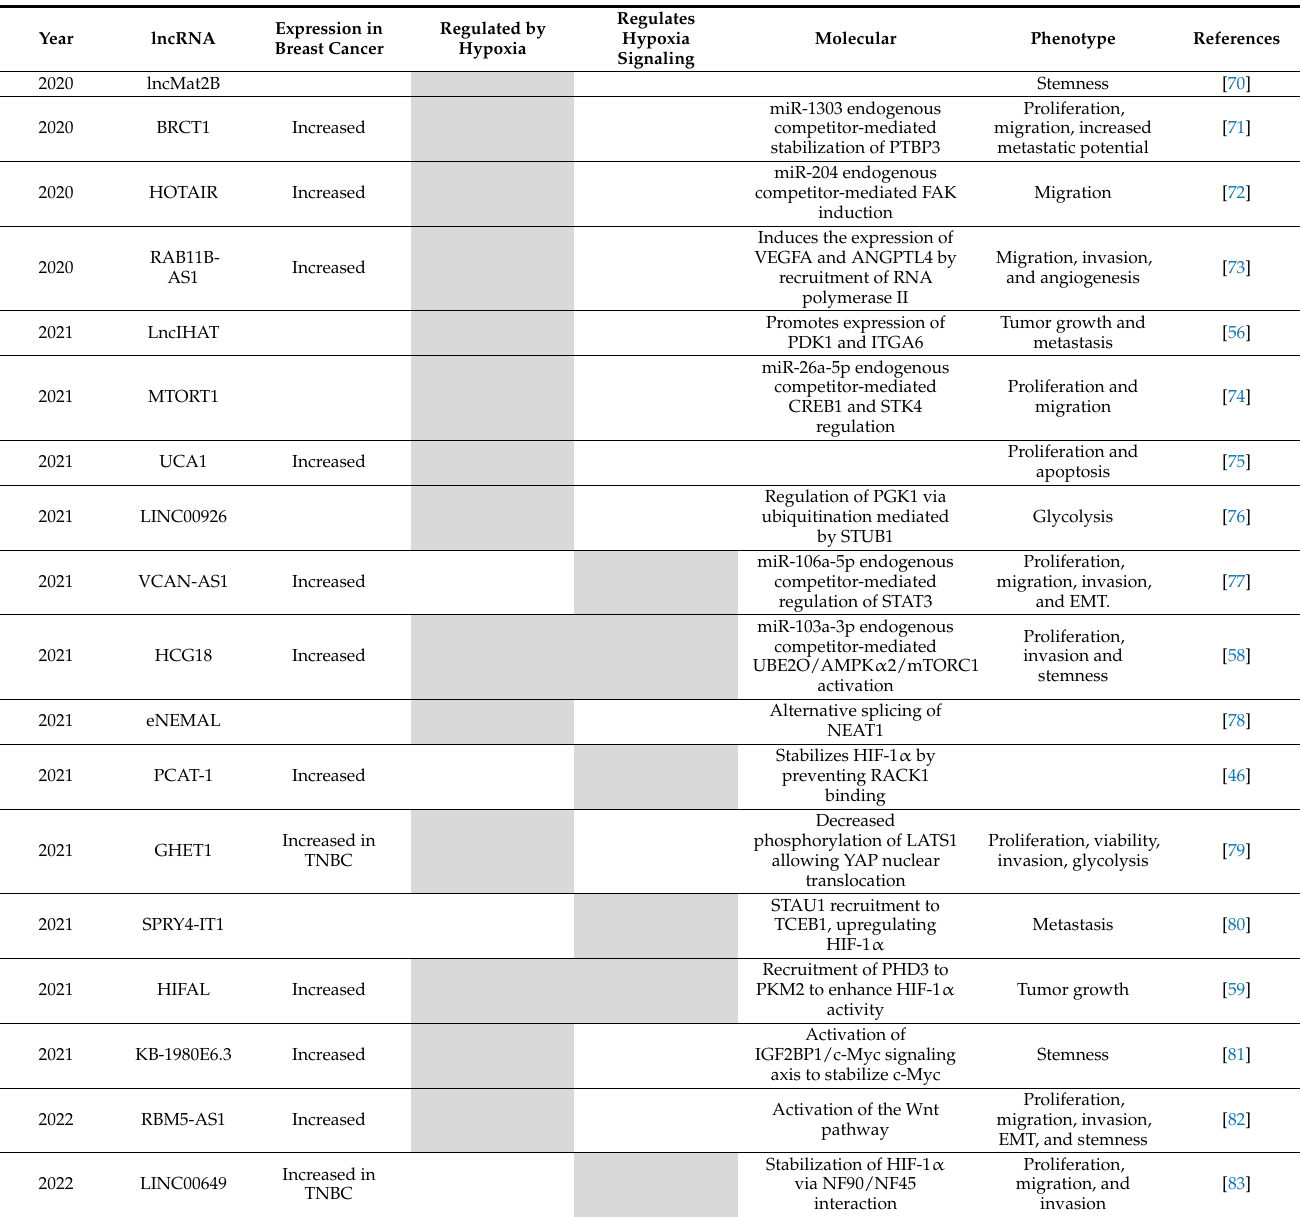
TNBC: Triple Negative Breast Cancer; TAMs: Tumor-Associated Macrophages. Gray bars show regulation (upstream or